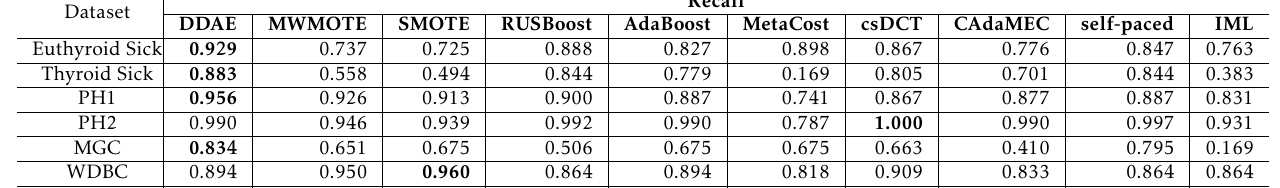
Table 22. Recall for for All Models on 8 Medical Public Datasets Dataset